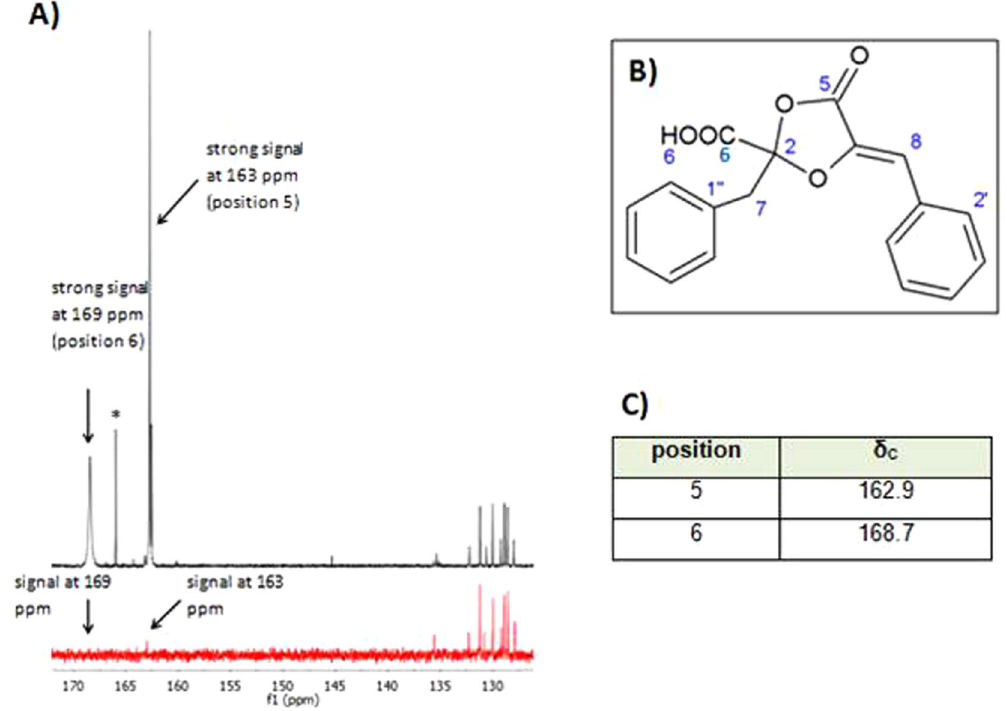
Figure 3. Spectrum of 13 C NMR measurement of 13 C-labelled and non-labelled phenguignardic acid with structural formula and 13 C NMR Data. ( A ) Strong signals were detected at 163 ppm and 169 ppm (black) in the NMR spectrum of phenguignardic acid, whereas these signals had lower intensity in the NMR spectrum of phenguignardic acid without labelling (red). This indicates an enrichment of 13 C at the C-5 and C-6 position in phenguignardic acid. ( B ) Structural formula of phenguignardic acid. ( C ) Segment of 13 C NMR data of phenguignardic acid 3